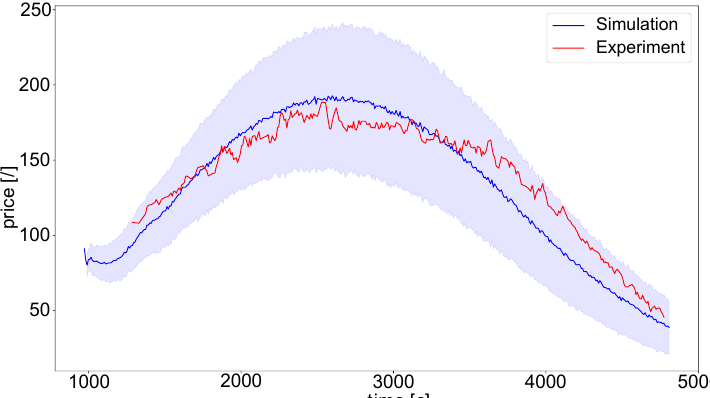
Figure 13. Comparison of service price between the experimental and simulation